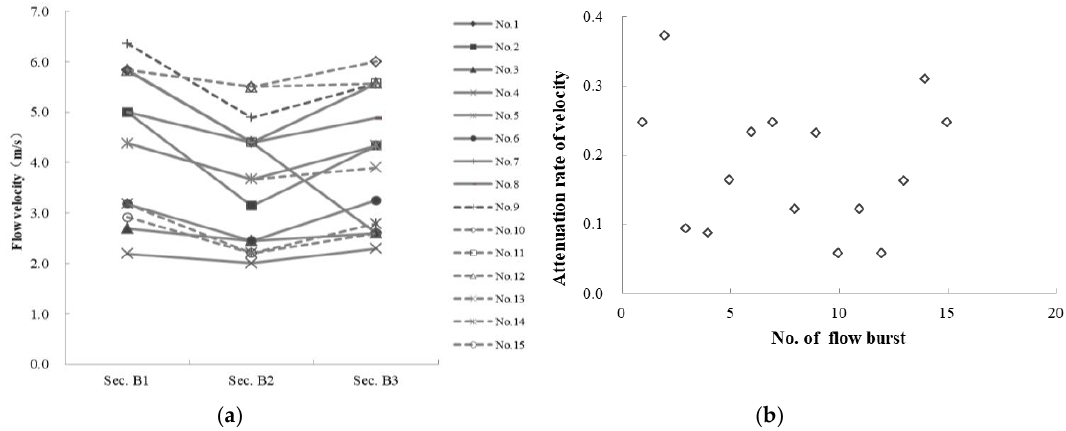
Figure 10. Observation data of velocity of debris flow. ( a ) Velocity change before and after ED section; ( b ) attenuation rate of velocity in the ED section. ( b ) attenuation rate of velocity in the ED